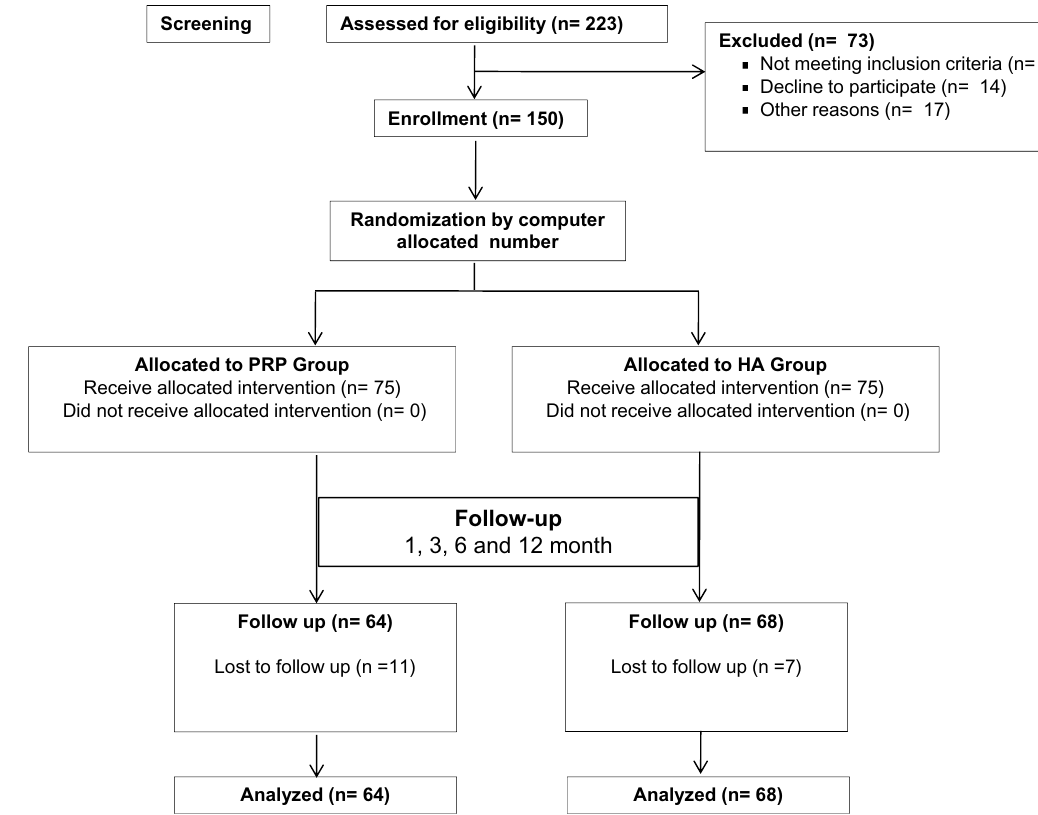
Figure 1. Flowchart of the clinical trial: Screening, assessment, treatment allocation and follow-up of patients with OA. n number of